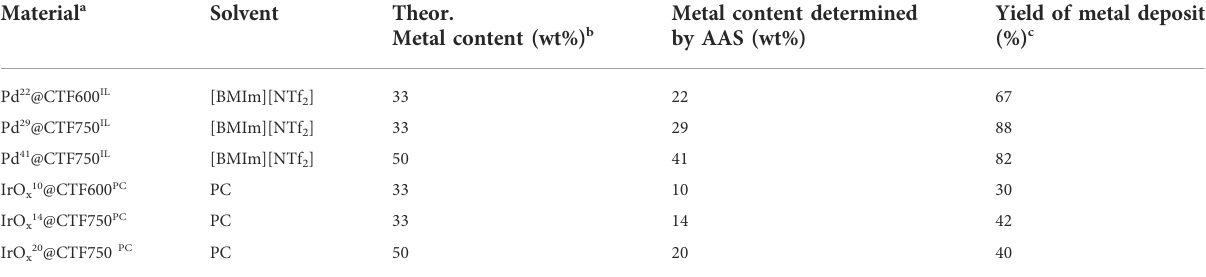
TABLE 1 Metal content in the Pd- and IrO x @CTF materials. Material